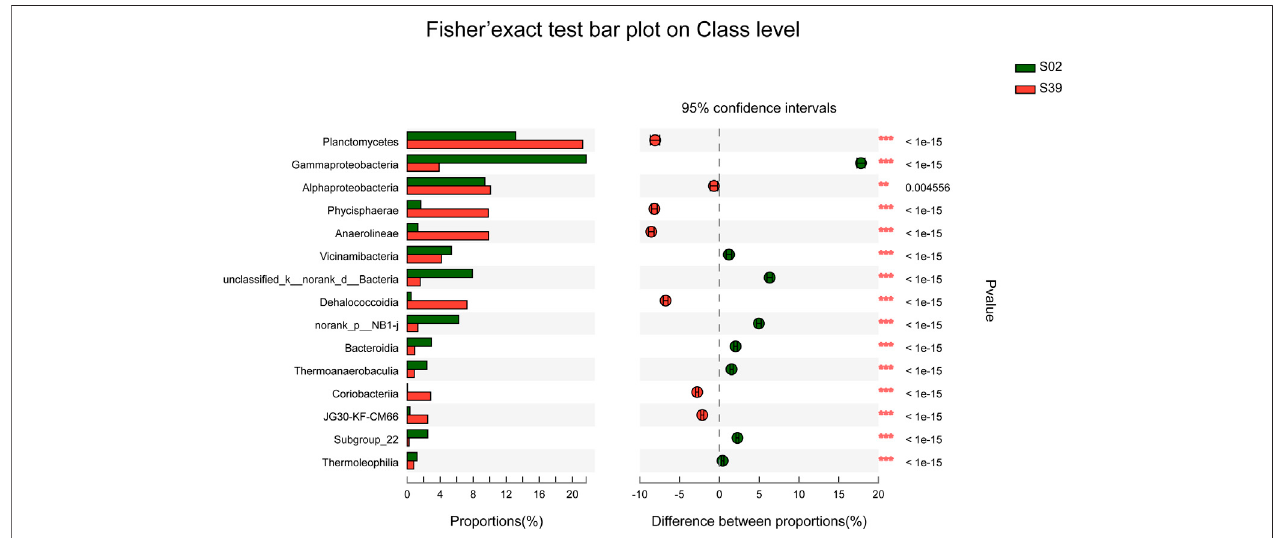
FIGURE 5 | Comparison of S02 and S39 community abundance at the class level. (Fisher ’ s exact test (two-tailed), * p ≤ 0.05,** p ≤ 0.01,*** p ≤ 0.001).